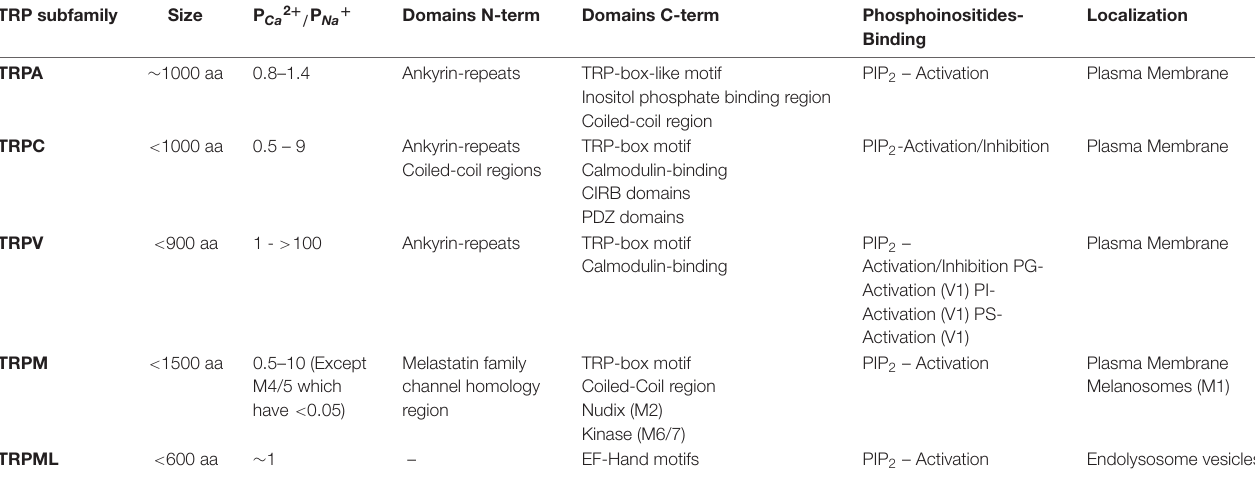
TABLE 1 | TRPA, TRPC, TRPV, TRPM and TRPML channels